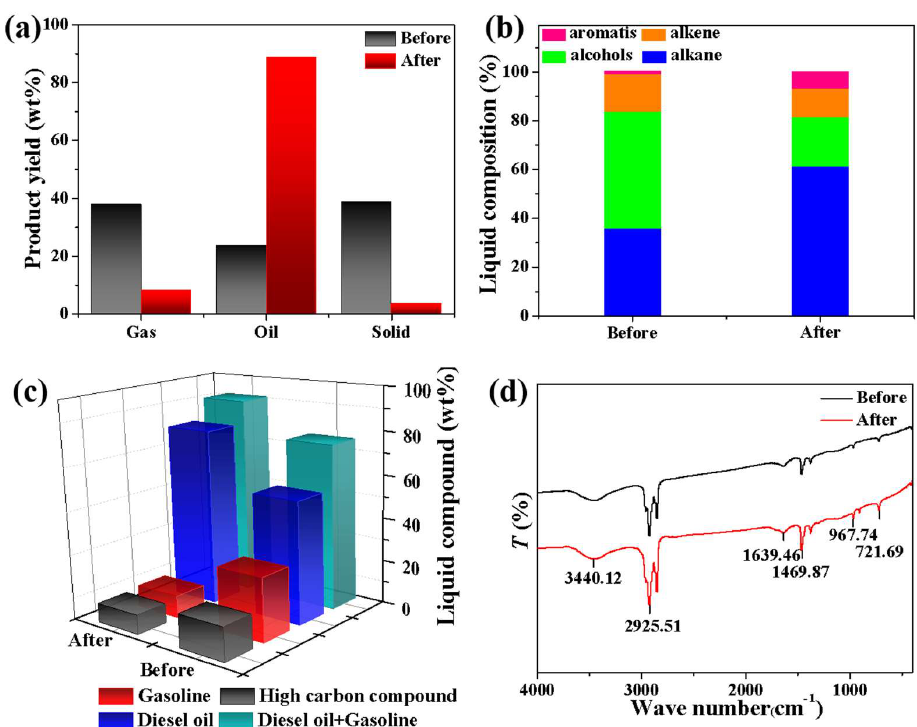
Figure 4. Product test of NMGM before and after hydrothermal thermal catalytic cracking of waste LDPE for 1 h ( a ) yield, ( b ) hydrocarbon composition distribution of liquid product, ( c ) liquid product composition distribution, ( d ) FTIR test.